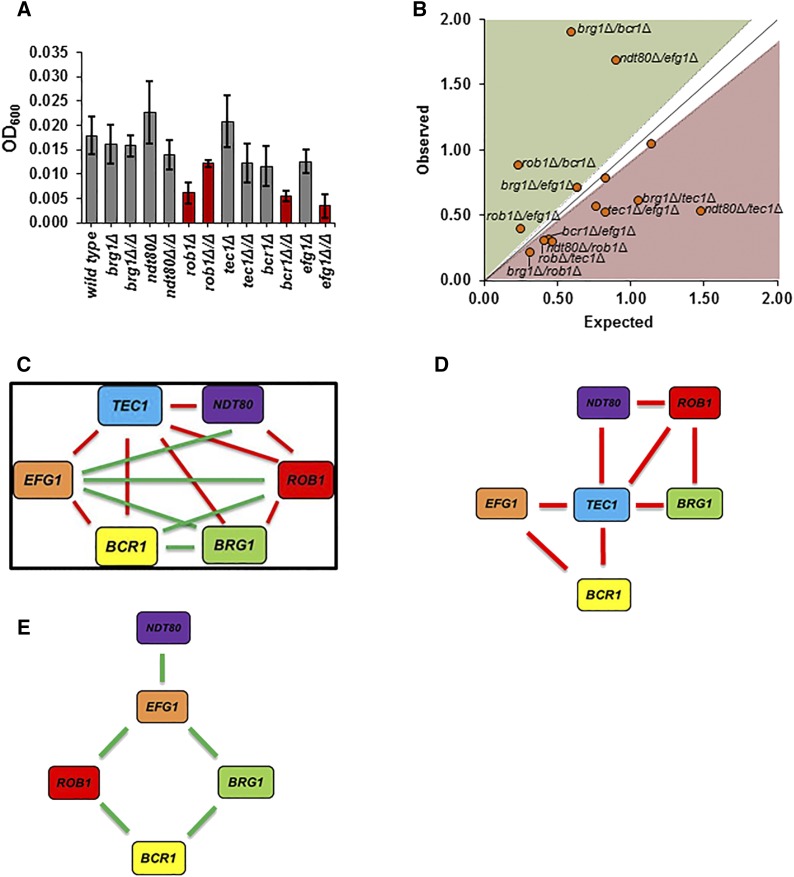
Haploinsufficiency and genetic interactions of biofilm TFs during the initial adherence stage of biofilm formation. A. The indicated strains were incubated in microtiter plates in YETS medium at 37°C for 90 min before non-adherent cells were removed by careful washing with PBS. The bars indicate the mean OD600 for each strain (triplicate) with error bars indicating standard deviation. Strains with a statistically significant (Student’s t-test P < 0.05) change from the reference strain are indicated by red bars. B. The expected adherence fitness (AF = Mutant OD600/Reference OD600) for a given double mutant (AFmutA X AFmutB) is plotted on x-axis for each biofilm TF double heterozgote and the observed AF for the double mutant is plotted on the y-axis. Mutants that fall within the zone defined by the diagonal (ε = 0 ± estimated error) have no genetic interaction while those above the diagonal (green) display alleviating interactions while those below (red) show aggravating interactions. C. Network of biofilm TF interactions during the adhesion step. Green edges indicate alleviating interactions; red edges indicate aggravating interactions. D. Aggravating interaction network centered on Tec1. E. Alleviating interaction network.